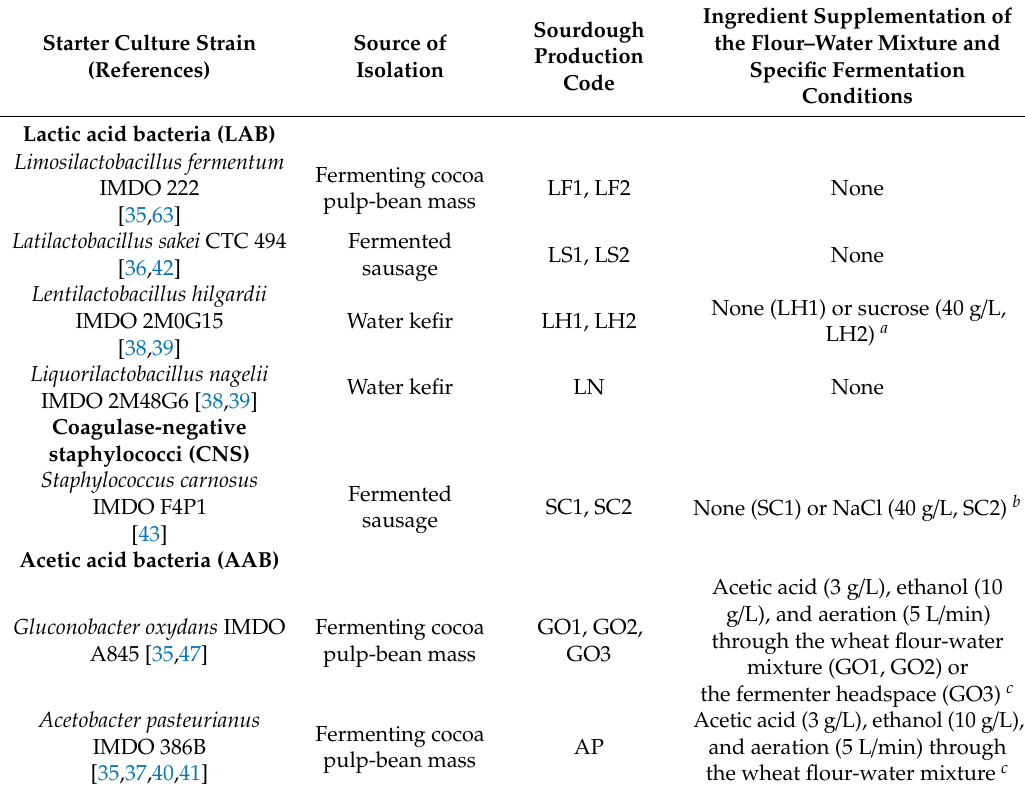
Table 1. Bacterial strains selected as to their sourdough starter culture potential, source of isolation of the starters, ingredients used, and specific fermentation conditions applied for starter culture-initiated, liquid (Type II / 2) sourdough